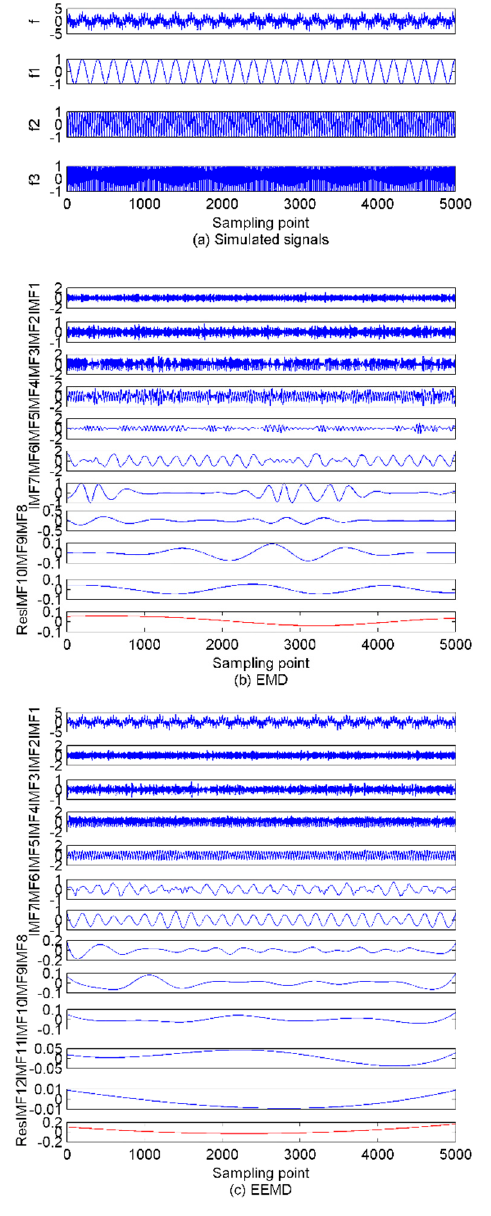
Figure 2. Modeled signals and decomposition results based on empirical mode decomposition (EMD) and ensemble empirical mode decomposition (EEMD) methods. ( a ) the initial modeled signals; ( b ) EMD procedure; ( c ) EEMD